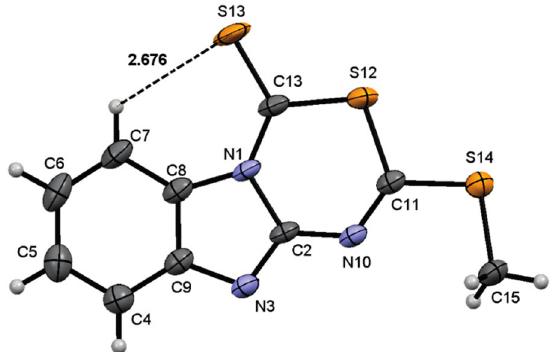
Figure 5. Molecular structure of compound 13 . Selected bond lengths (Å) and angles